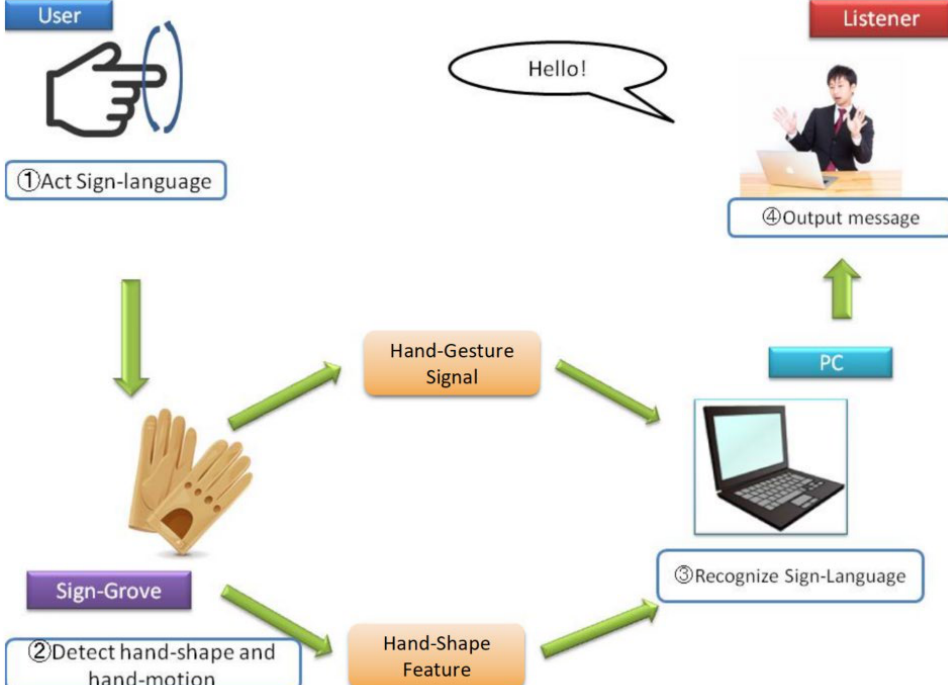
Figure 2. Usage of Sign-Glove for sign language recognition.